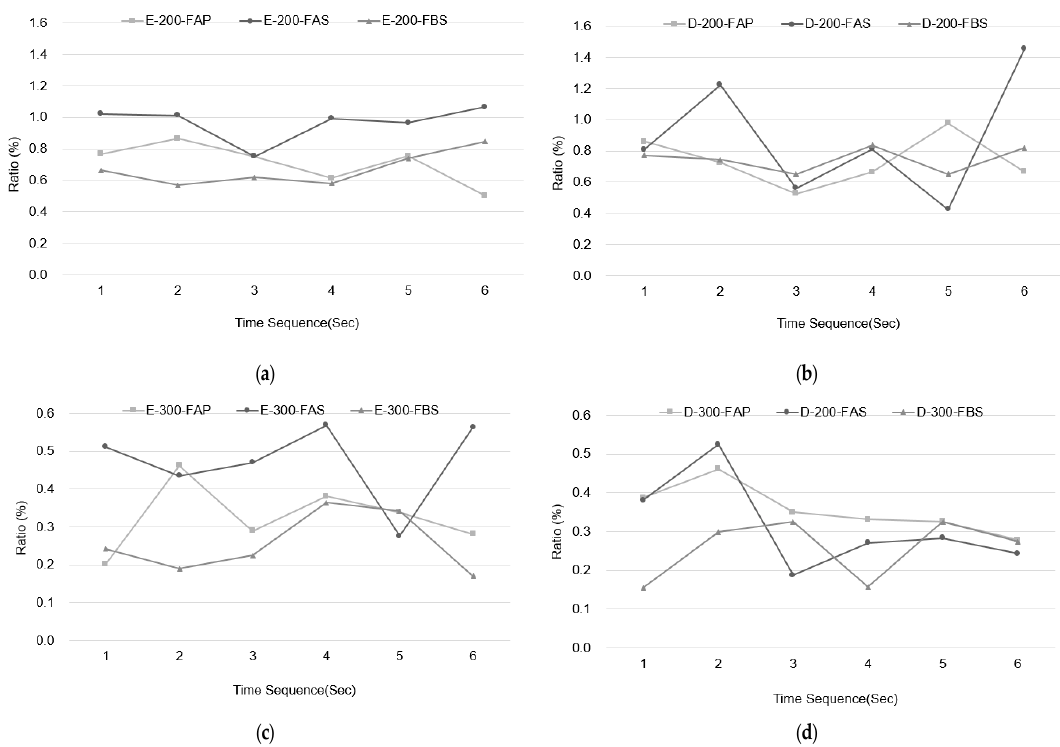
Figure 8. Analysis of visual perception and understanding in AOIs according to cognitive differences. ( a ) Visual data for 200 ms in the AOIs for the “easy” group. ( b ) Visual data at 200 ms in the AOIs for the “difficult” group. (c) Visual data at 300 ms in the AOIs for the “easy” group. (d) Visual data at 300 ms in the AOIs for the “difficult” group.